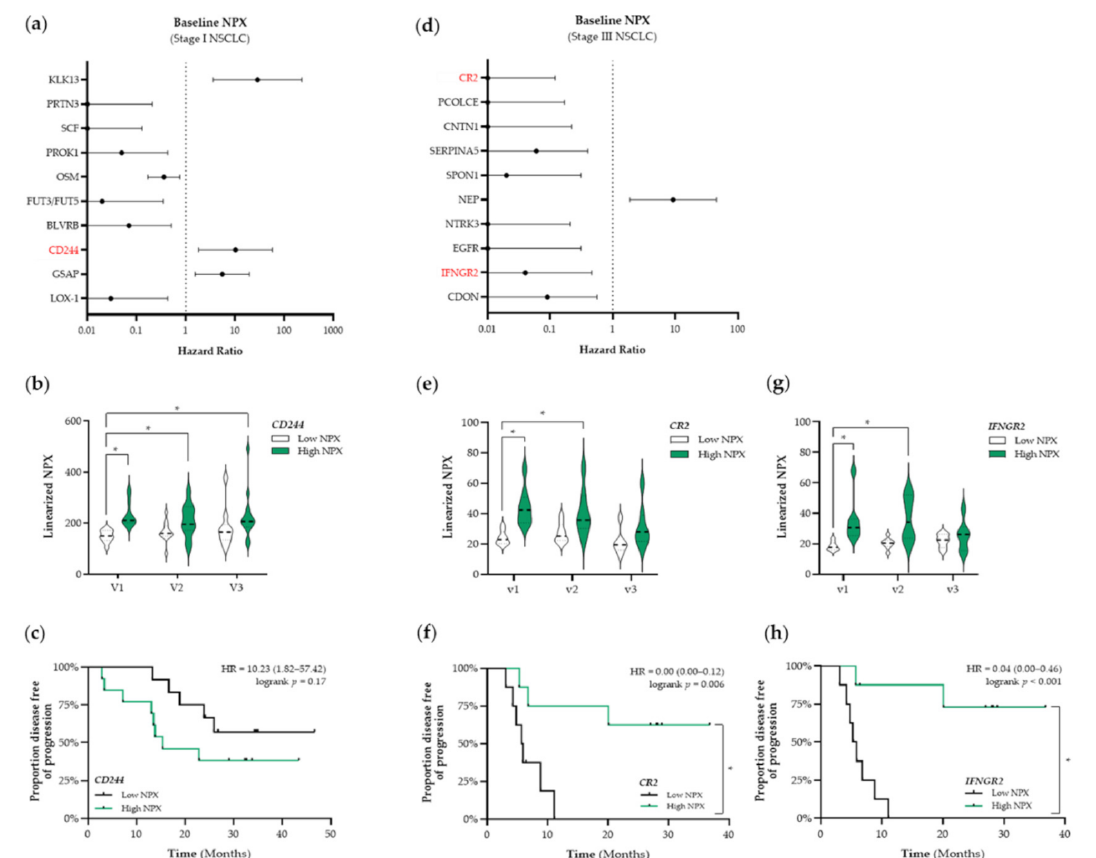
Figure 4. Identification of prognostic immune-related proteins in patients with NSCLC. ( a ) The Cox Proportional-Hazards model was used to identify proteins associated with PFS at baseline (v1) in patients with stage I NSCLC ( n = 25). The top 10 proteins associated with PFS in patients with stage I are displayed in a forest plot. The closed circles represent the Hazard Ratio of each identified protein and the horizontal lines illustrate the 95% confidence interval. Immune-related proteins are indicated in red. ( b , c ) Patients with stage I NSCLC ( n = 25) were stratified into low (black) or high (green) CD244 (Signaling Lymphocyte Activation Molecule (SLAM) family immunoregulatory receptor) NPX-based “risk groups” by considering the median NPX value of the CD244 protein at v1 as a cut-off. ( b) The linearized CD244 NPX values are presented in a violin plot, showing the distribution of the CD244 NPX values at each timepoint. The median is indicated by the dashed line, the quartiles are indicated by the dotted lines. ( c ) Kaplan–Meier plot of the low CD244 NPX group and high CD244 NPX group on the patients’ PFS. ( d ) The Cox Proportional-Hazards model was used to identify proteins associated with PFS at baseline (v1) in patients with stage III NSCLC ( n = 18). The top 10 proteins associated with PFS in patients with stage III are displayed in a forest plot. Immune-related proteins are indicated in red. ( e–h ) Patients with stage III NSCLC ( n = 18) were stratified into low (black) or high (green) NPX-based “risk groups” by considering the median NPX value of the protein at v1 as a cut-off. ( e ) The linearized CR2 (complement receptor 2) NPX values are presented in a violin plot, showing the distribution of the CR2 NPX values at each timepoint. ( f ) Kaplan–Meier plot of the low CR2 NPX group and high CR2 NPX group on the patient’s PFS. ( g ) The linearized IFNGR2 NPX values are presented in a violin plot, showing the distribution of the IFNGR2 NPX values at each timepoint. ( h ) Kaplan–Meier plot of the low IFNGR2 NPX group and high IFNGR2 NPX group on the patient’s PFS. In all Kaplan–Meier plots, respective logrank test p -values and Hazard Ratios (HR with its 95% confidence interval in parenthesis) are displayed. To compare differences between groups, the non-parametric Kruskal–Wallis test was applied followed by Dunn’s post-hoc testing with Bonferroni correction. A nominal p -value less than 0.05 was considered to be statistically significant and is indicated through an asterisk